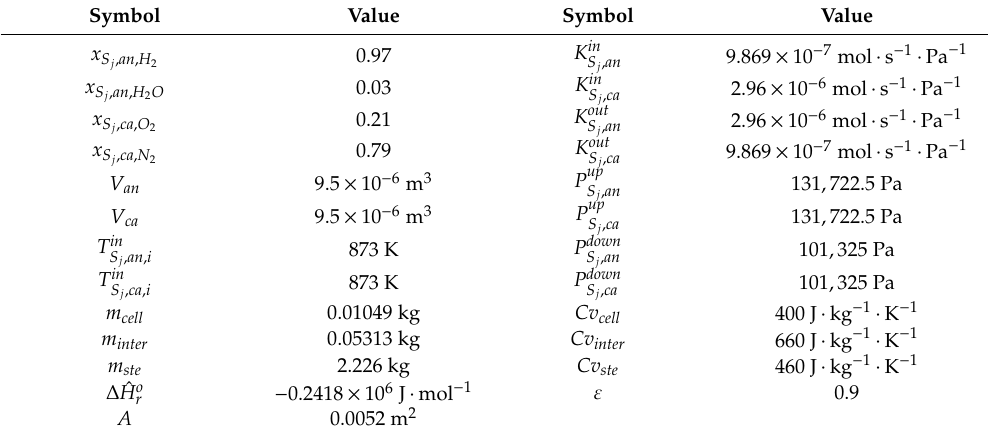
Table 1. Stack parameters and operating conditions.